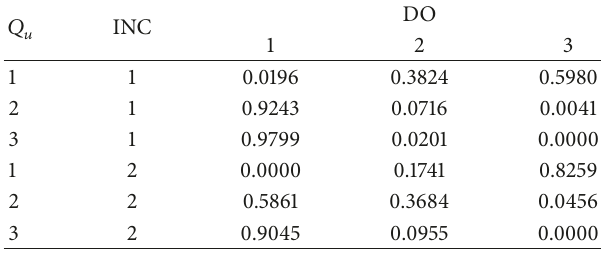
Table 2: The split points of continuous variables in TAN classifier.